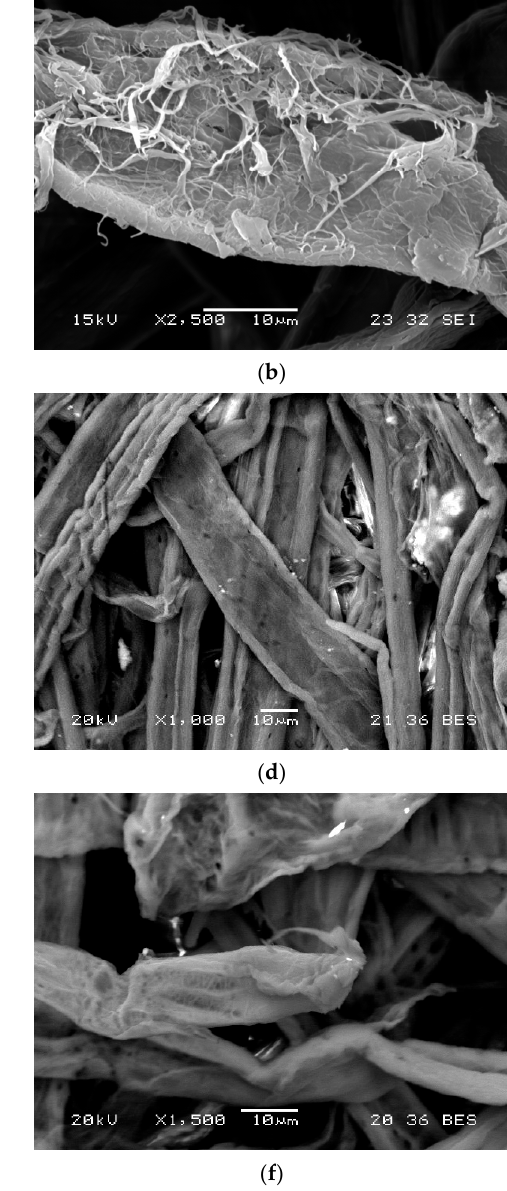
Figure 1. Scanning electron microscopy of plant cell walls at different magnifications. ( a ) General view of softwood fibers (magnification 500×). ( b ) Broken ends of softwood fibers (magnification 2500×). ( c ) Cellular elements in rapeseed pulp (magnification 550×). ( d ) Fibers in rapeseed pulp (magnification 1000×). ( e ) Perforations in corn fibers (magnification 500×). ( f ) Fibers in corn pulp (magnification 1500×).